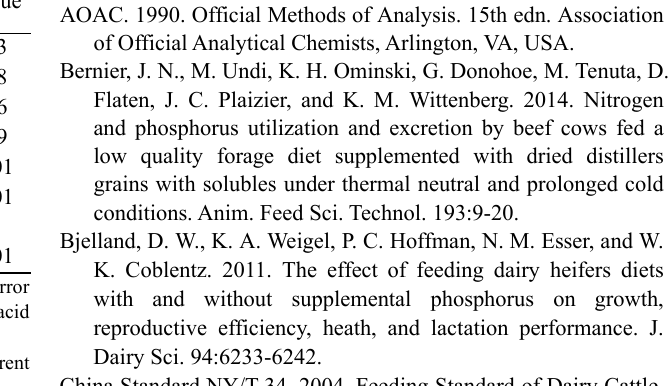
Table 5. Fecal phosphorus (P) and urine P and apparent digestibility coefficients for CP, P, NDF, and ADF of heifers fed different dietary P concentrations